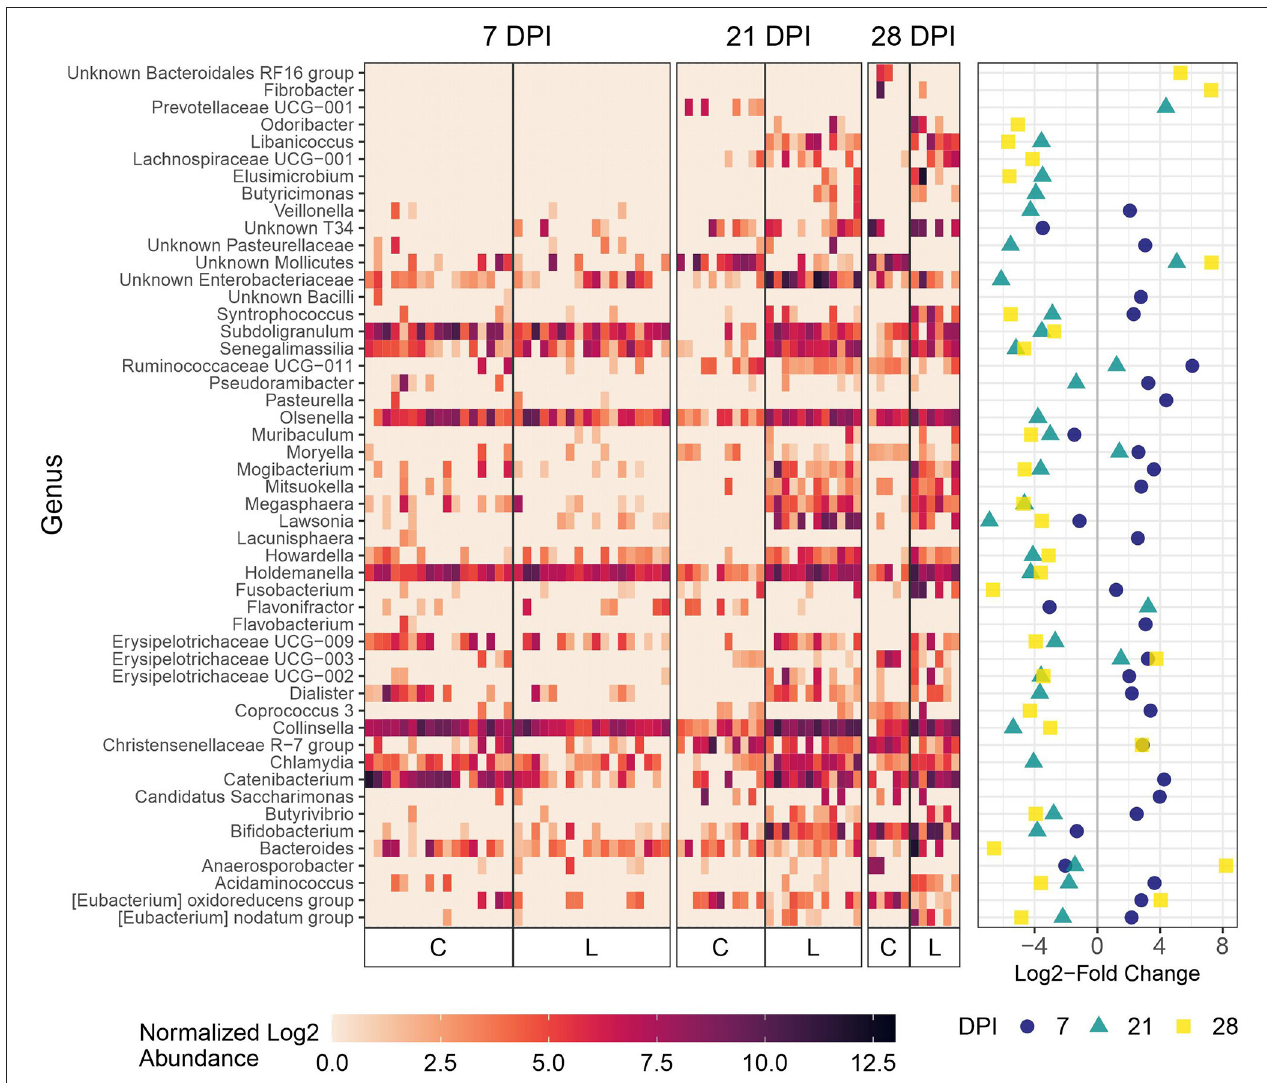
FIGURE 4 | Differential abundance of microbial genera in feces between the Law (L) and Control (C) groups at 7, 21, and 28 dpi. The 20 genera with the largest significant log2-fold change at each dpi are included. The heatmap shows the cumulative sum scaling (CSS)-normalized log2 abundance of each genera per sample, with the significant log2-fold changes by dpi plotted on the right panel. Note that a genus only has to be one of the top 20 significantly differentially abundant at 1 dpi for it to be included in the figure. A positive log2-fold change indicates greater abundance in the Control group, and a negative log2-fold change indicates greater abundance in the Law